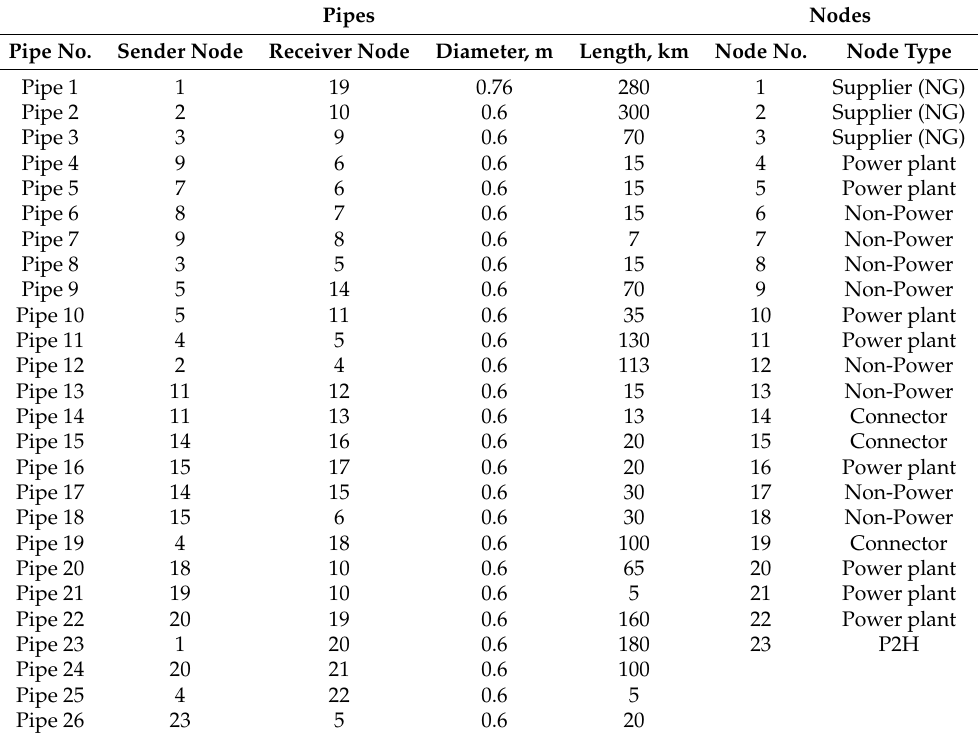
Figure A2. Corrib ( a ) and Moffat ( b ) flow rate reduction after injecting hydrogen. Table A1. Gas network pipes and